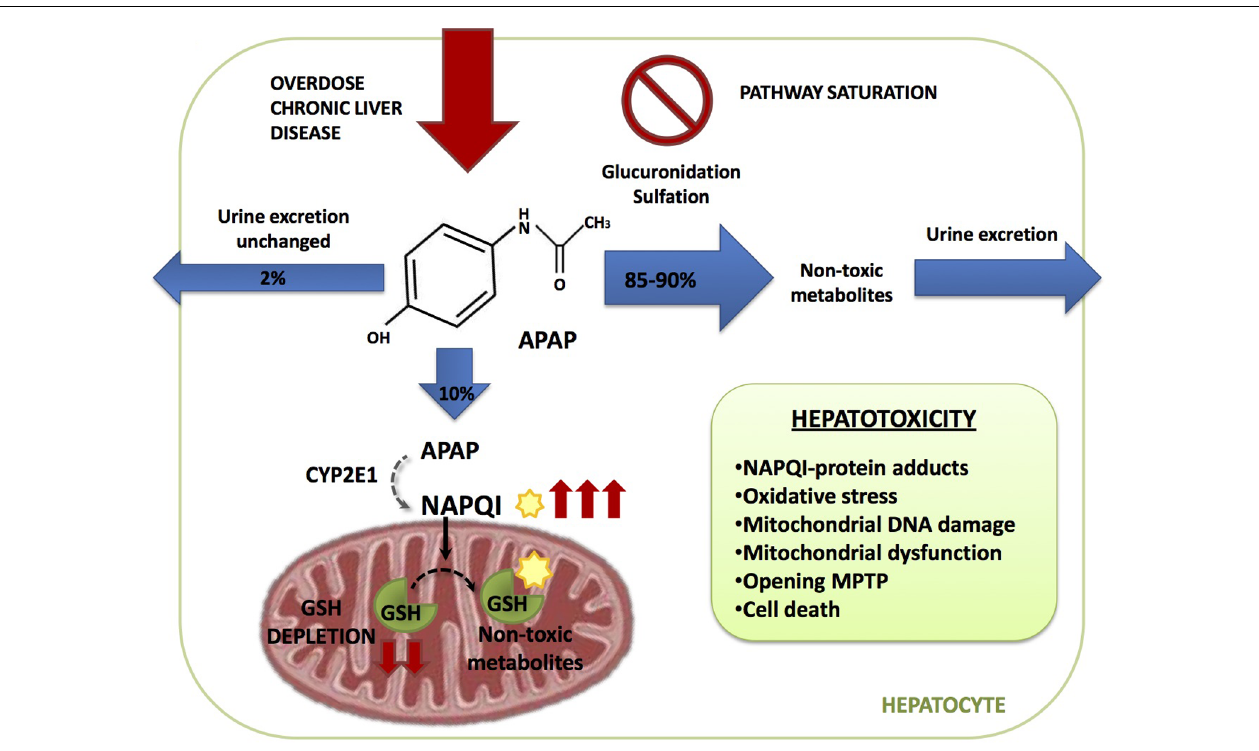
FIGURE 1 | Acetaminophen (APAP) metabolic pathway. APAP is metabolized in the hepatocyte through three different pathways. 2% is excreted through the urine unchanged, 85–90% is converted in glucuronidated and sulfated non-toxic metabolites and 10% is oxidized by cytochrome CYP2E1 generating the highly reactive and toxic metabolite N -acetyl- p -benzoquinone imine (NAPQI). NAPQI is then conjugated with gluthatione (GSH) resulting in non-toxic metabolites. During APAP overdose or susceptible in patients, as the ones with chronic liver disease, glucuronidation and sulfation pathways become saturated and more APAP is metabolized through CYP2E1 which increases NAPQI generation depleting GSH liver stores. Free unconjugated NAPQI reacts with proteins generating NAPQI-protein adducts in hepatocytes leading to mitochondrial dysfunction and cell